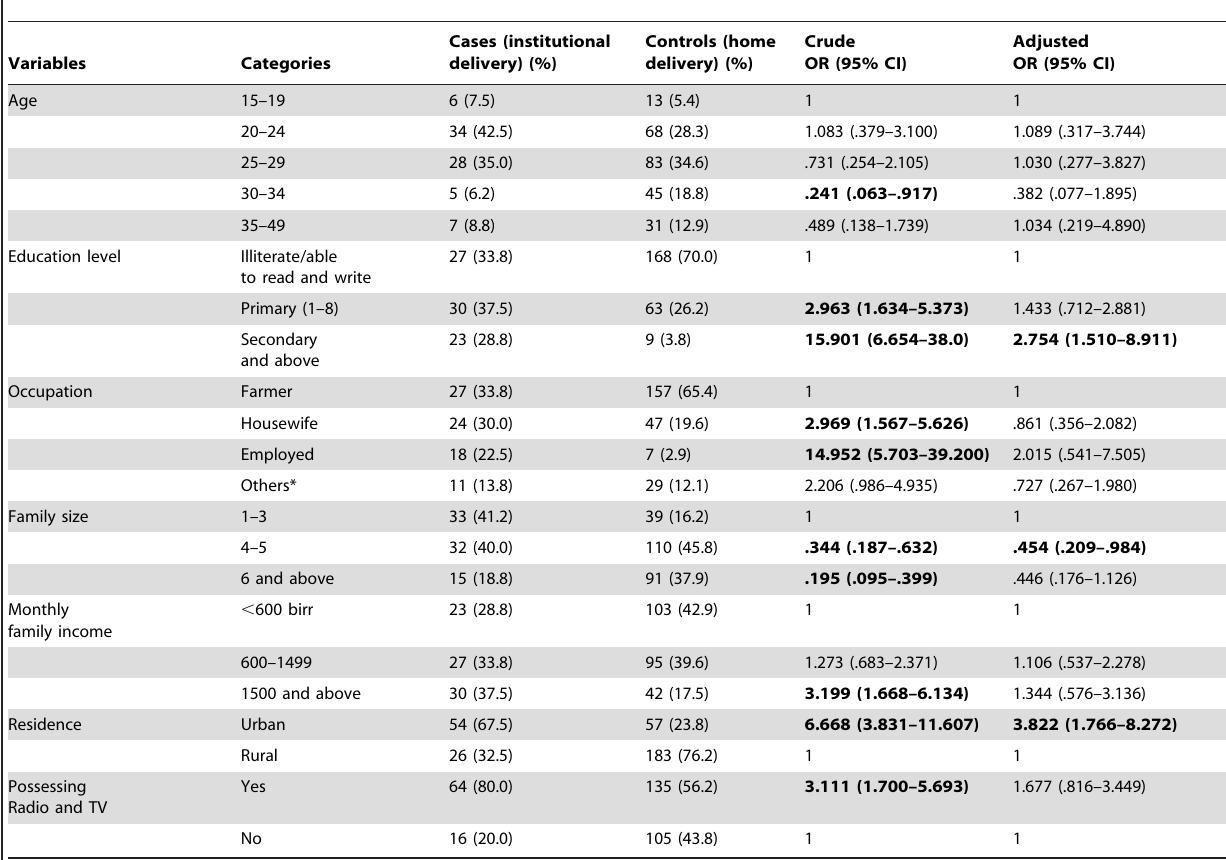
Table 2. Socio-demographic determinants of institutional delivery in Western Ethiopia, October